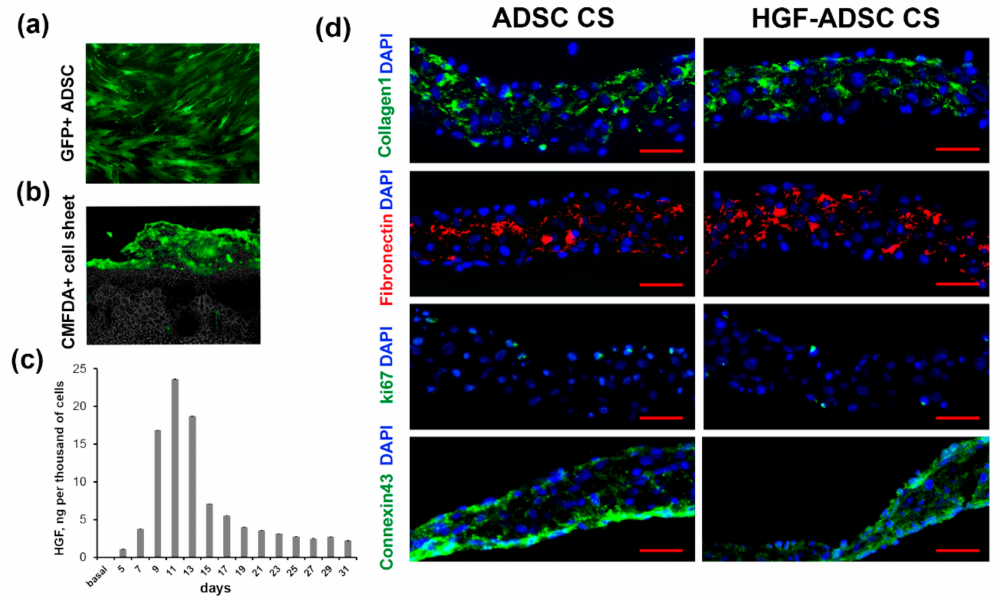
Figure 1. Characteristicsofcellsheetscomprisedofadipose-derivedstromalcells(ADSC).( a )GFP-expressing ADSC transduced by rAAV-GFP; ( b ) CMFDA-labeled cell sheet covering skeletal muscle; ( c ) hepatocyte growth factor (HGF) production by gene modified ADSC evaluated by ELISA; ( d ) representative images of cell sheet frozen sections stained against collagen (green), fibronectin (red), ki67 (green), connexin 43 (green) and DAPI (blue). Scale bar = 50 µ